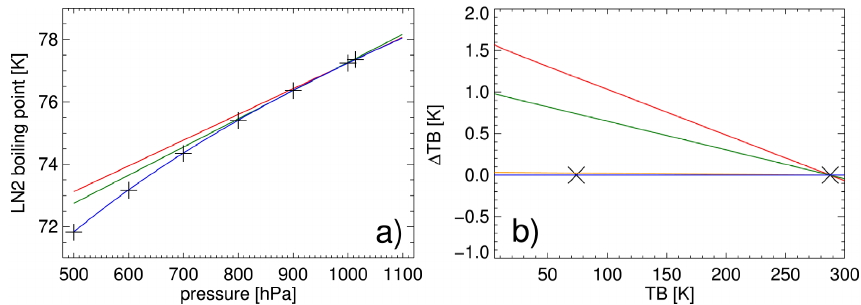
Fig. 3. Boiling point correction for LN 2 : different radiometer manufacturers have used different formulations for the pressure-dependent correction of the LN 2 boiling point. Absolute boiling points (a) and their impact on derived T b ( b , T b reference from Eq. 15). Red: Eq. (12) (Radiometer Physics GmbH, 2011), green: Eq. (13) (Radiometrics, 2007), blue: new formulation (Eq. 15), orange: reference values (Span, 2000), crosses: calibration point T C and T H . (b) Impact on the derived T b from differences in the assumed temperature of the cold calibration target ( T C ). Lines: LN 2 calibration simulations using the different corrections for the 23.04GHz HATPRO-G2 channel, X: cold and hot calibration